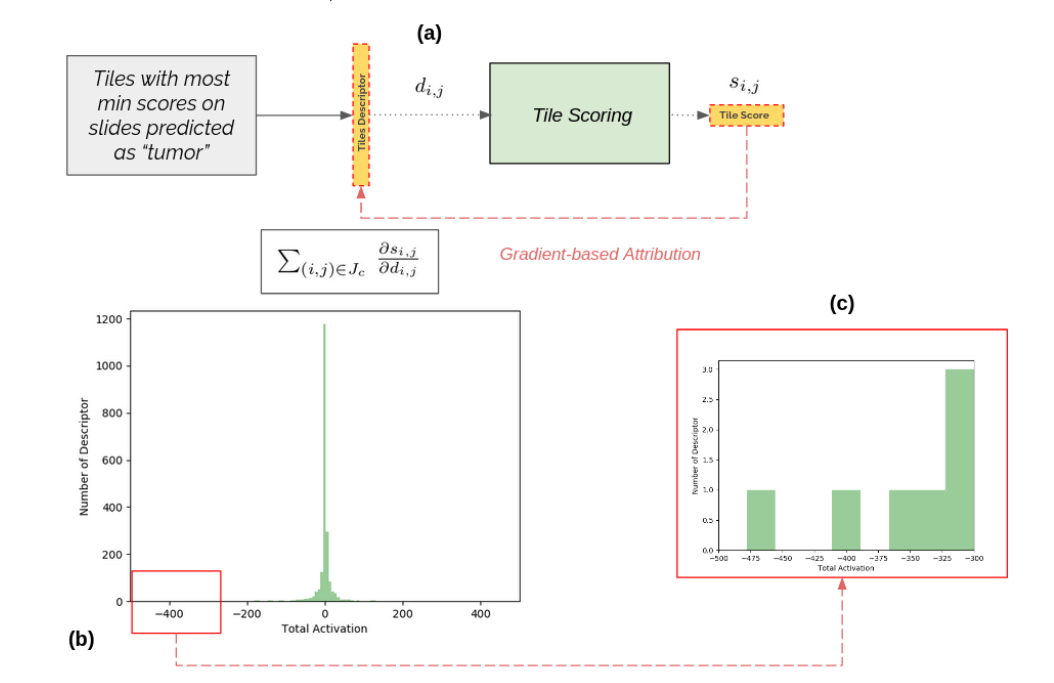
Figure 4. Attribution on tile descriptor items for the “tumor” class; ( a ) Illustration of gradient on the learned “Tile Scoring” block; ( b ) Distributions of attributions for tile descriptors with lowest score; ( c ) Zoom on the range of